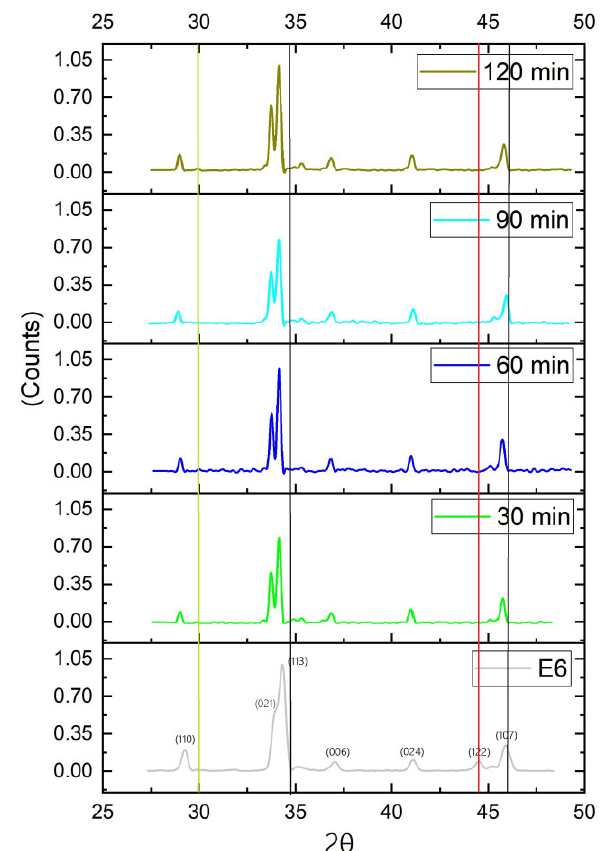
Figure 5. XRD spectra for potassium jarosite and the powder obtained after 30, 60, 90, and 120 min reaction of incorporation of of reaction of incorporation of As(V) .